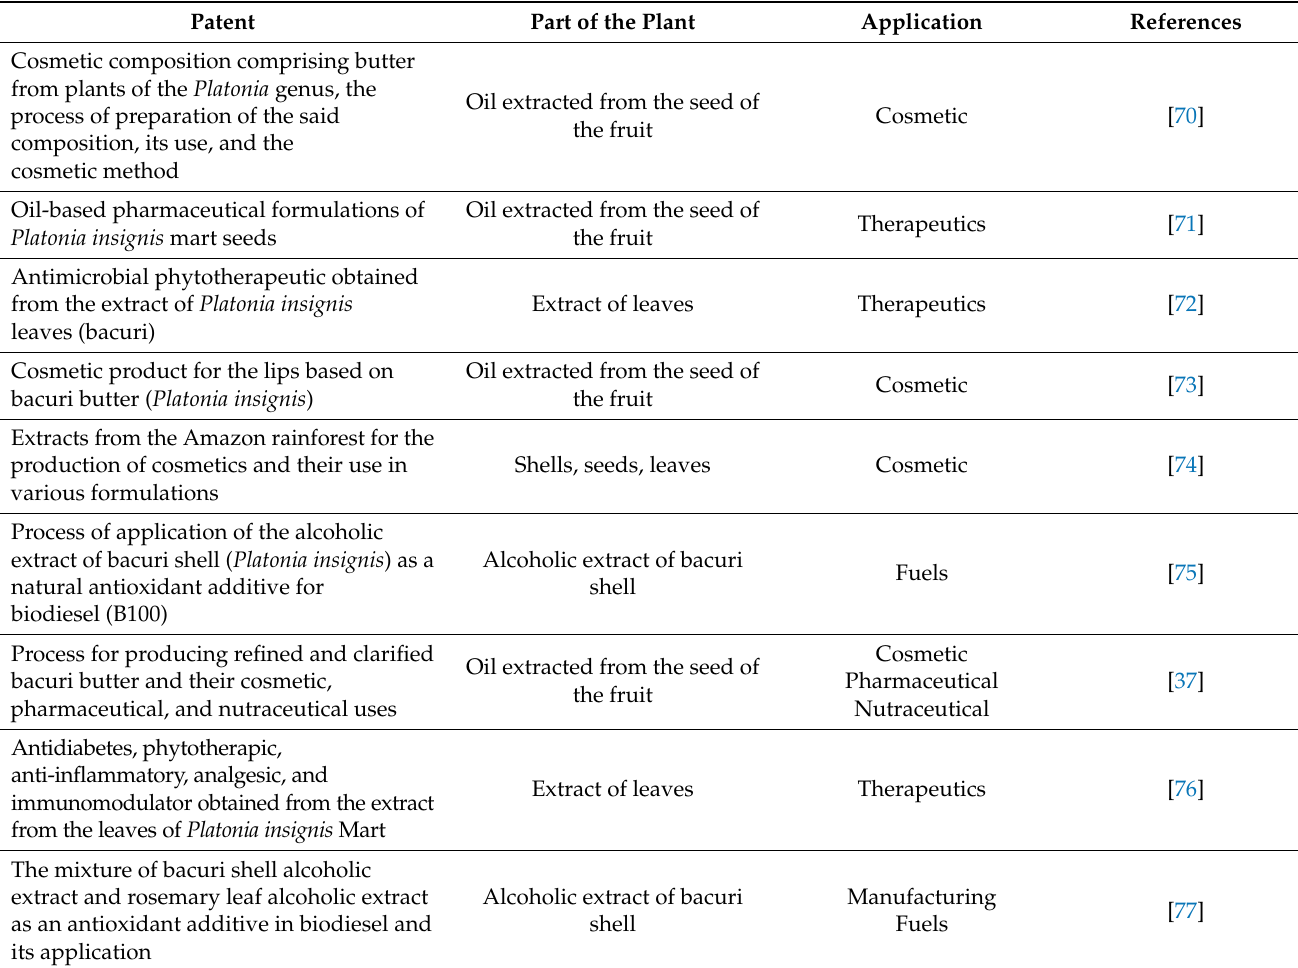
Table 8. Records of patent applications and/or patents granted with products developed from bacuri ( Platonia insignis